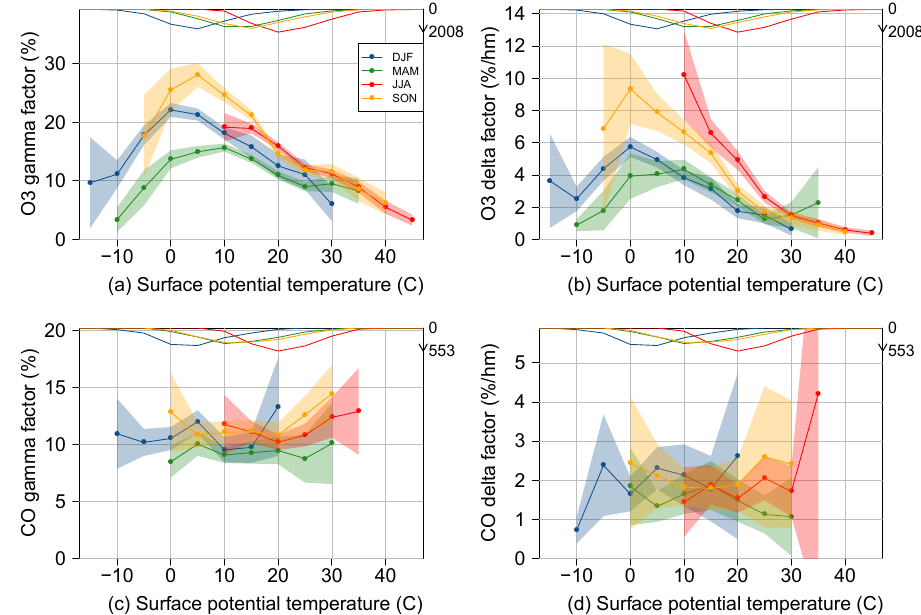
Figure 13. Daytime factors of vertical stratification as a function of surface potential temperature. Results are shown for O 3 ( a, b ) and CO ( c, d ) and for both γ (in %; a, c ) and δ (in %hm − 1 ; b, d ). The shaded area represents the uncertainties (at a 95% confidence level) on the mean. The curves at the top of the graph show the number of profiles taken into account (the highest number of profiles is indicated by the